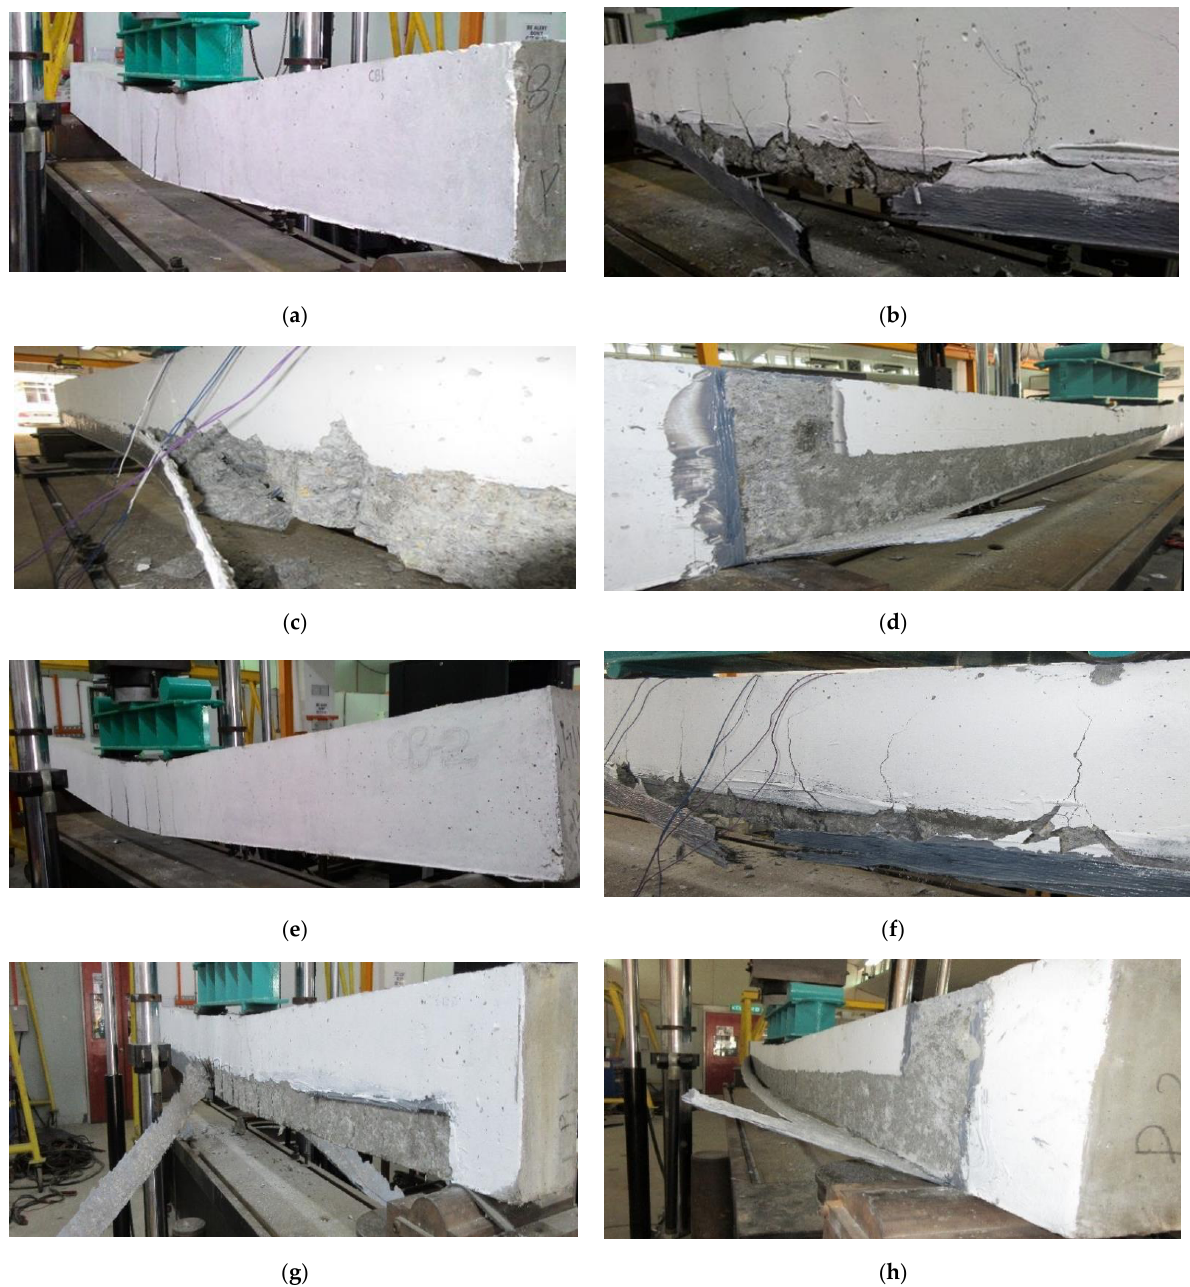
Figure 8. Failure modes of the beams; ( a ) CB-A; ( b ) SE-A; ( c ) SE-2A; ( d ) SE-3A; ( e ) CB-B; ( f ) SE-B; ( g ) SE-2B; ( h ) SE-3B.